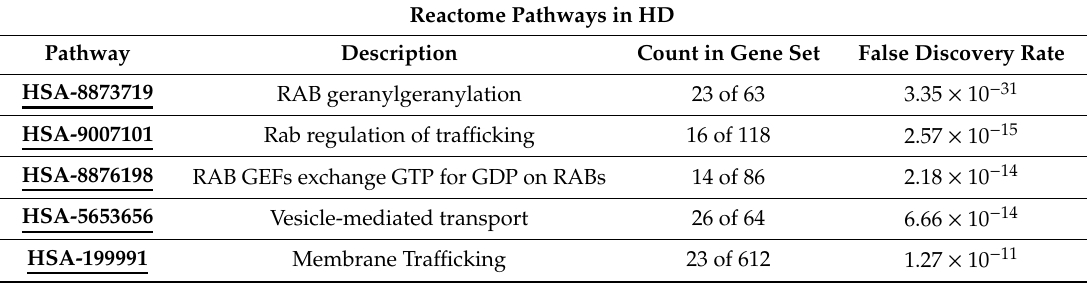
Table 3. Highlights of the five most significant reactome pathways involving proteins overexpressed in the HD group.